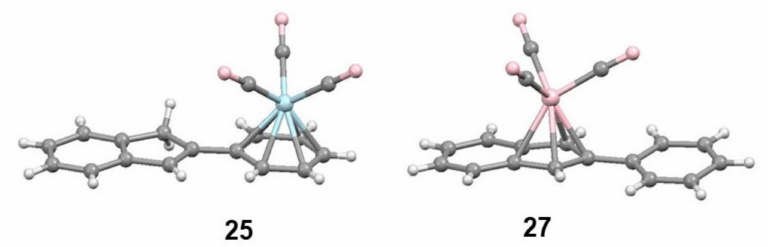
Figure 11. Molecular structures of [ η 6 -(2-indenyl)benzene]tricarbonylchromium, 25 , and ( η 5 -2- phenylindenyl)tricarbonylrhenium, 27